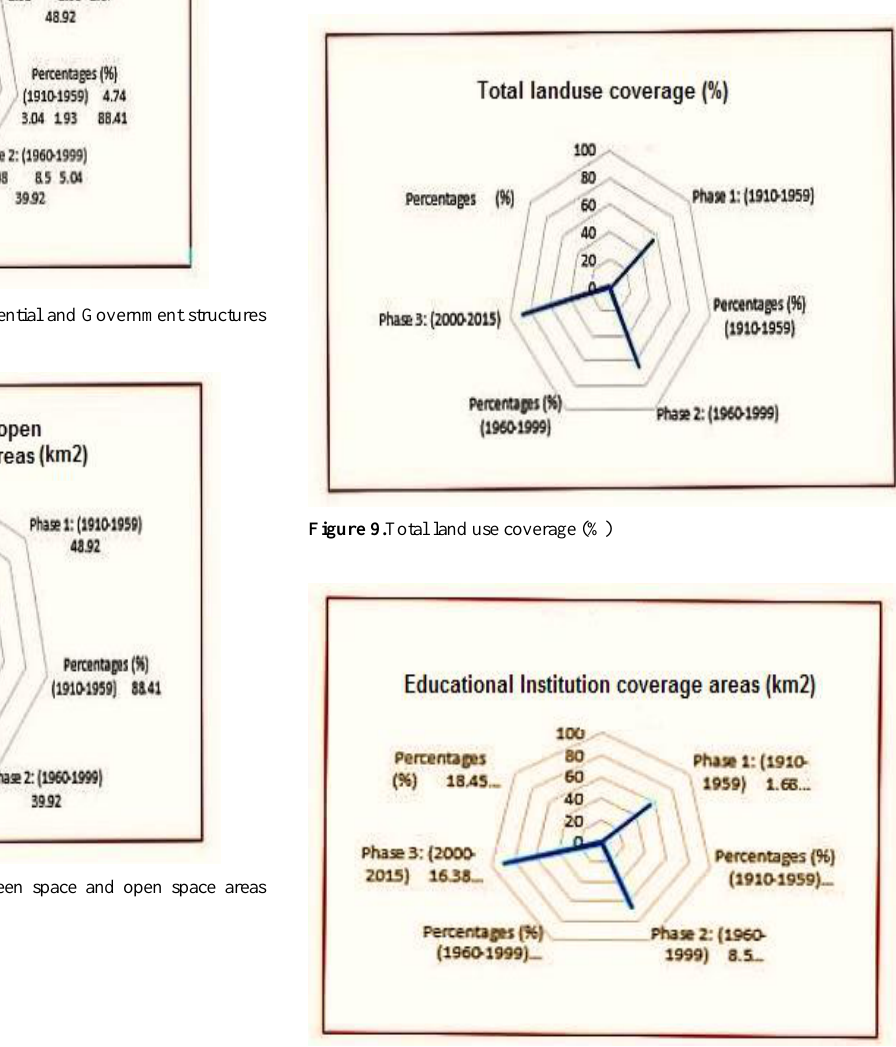
Figure 10 . Land use coverage by the educational structures (Km 2